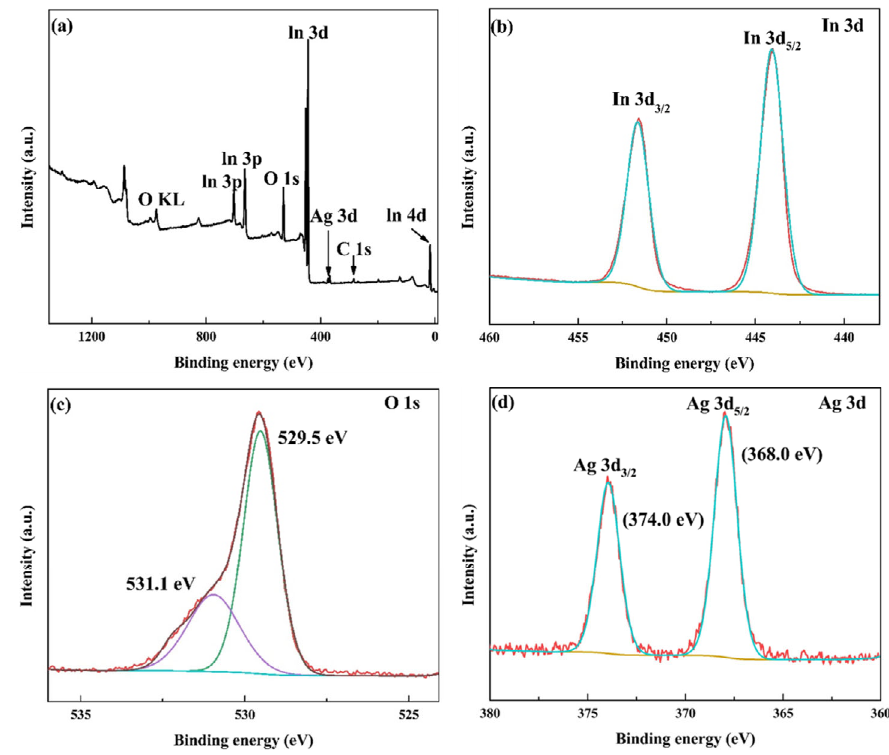
Fig. 7 XPS spectra of 5Ag–In: (a) full survey scan spectrum, (b) In 3d, (c) O 1s, and (d) Ag 3d.